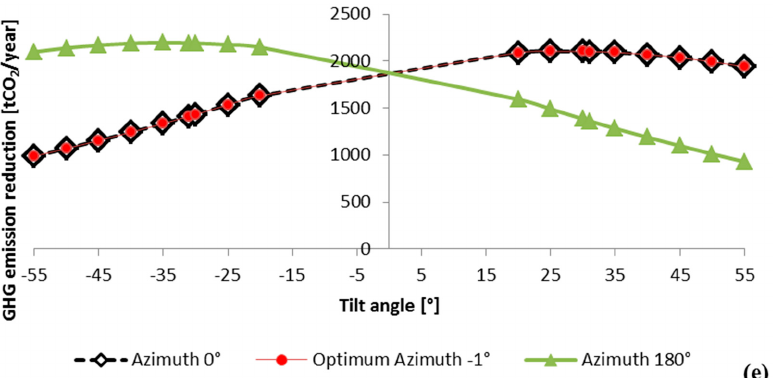
Figure 8. Azimuth and tilt angle impact on ( a ) annual average daily solar radiations, ( b ) annual average solar radiations, ( c ) output power of PV system, ( d ) capacity factor (CF), and ( e ) annual GHG emission reduction.